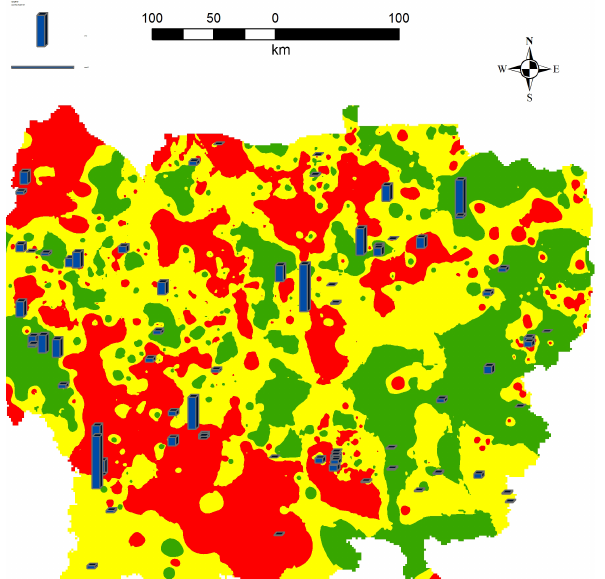
Figure 15. Nitrate distribution in the normalized model.